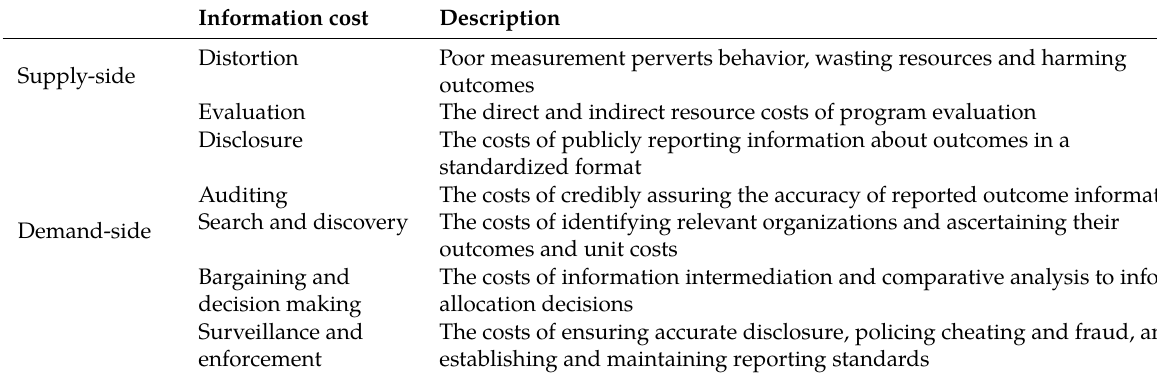
Table 1: Information